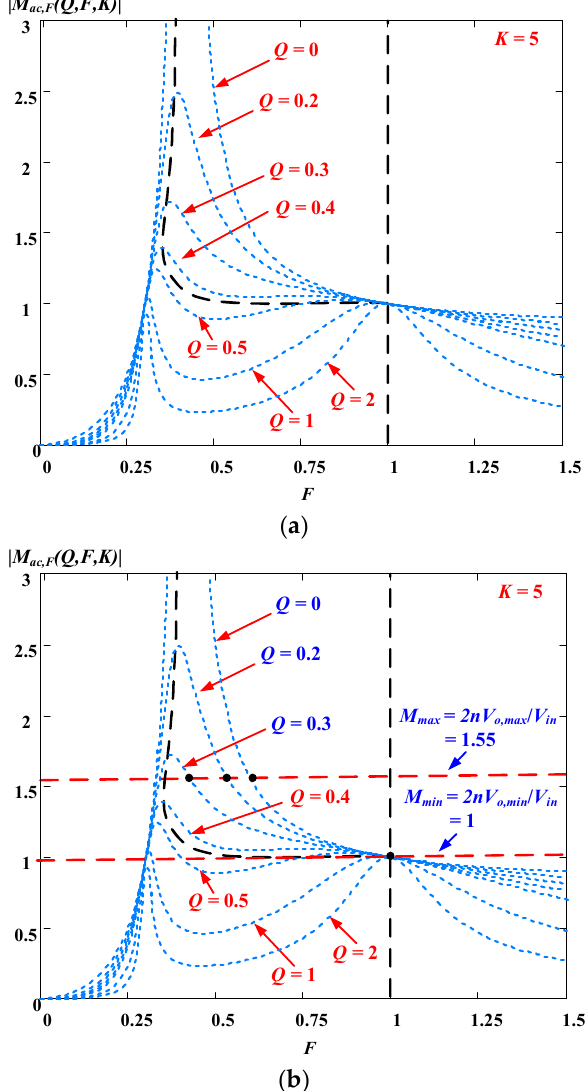
Figure 9. Gain curves: ( a ) the proposed converter ( b ) in the laboratory prototype.